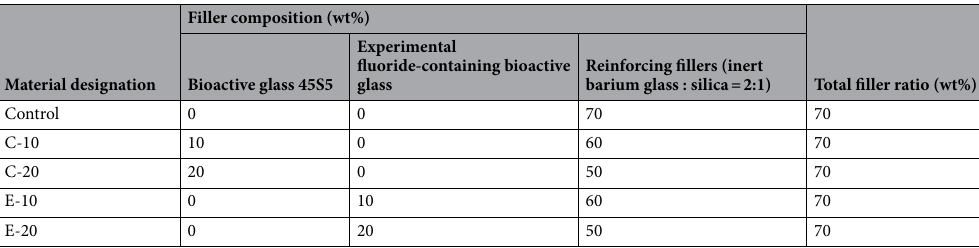
Table 2. Composition of experimental